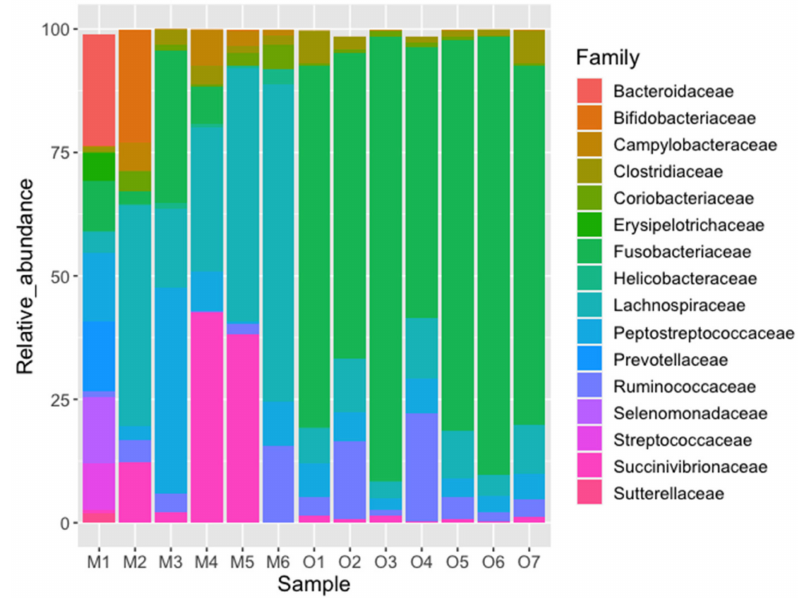
Figure 4. Relative abundance (%) of the fecal bacterial taxa (family level) from two populations of Mexican wolves ( Canis lupus baileyi ) in Michilia (M, 23 ◦ N) and Ocotal (O, 19 ◦ N), Mexico; only the first 16 more abundant families are